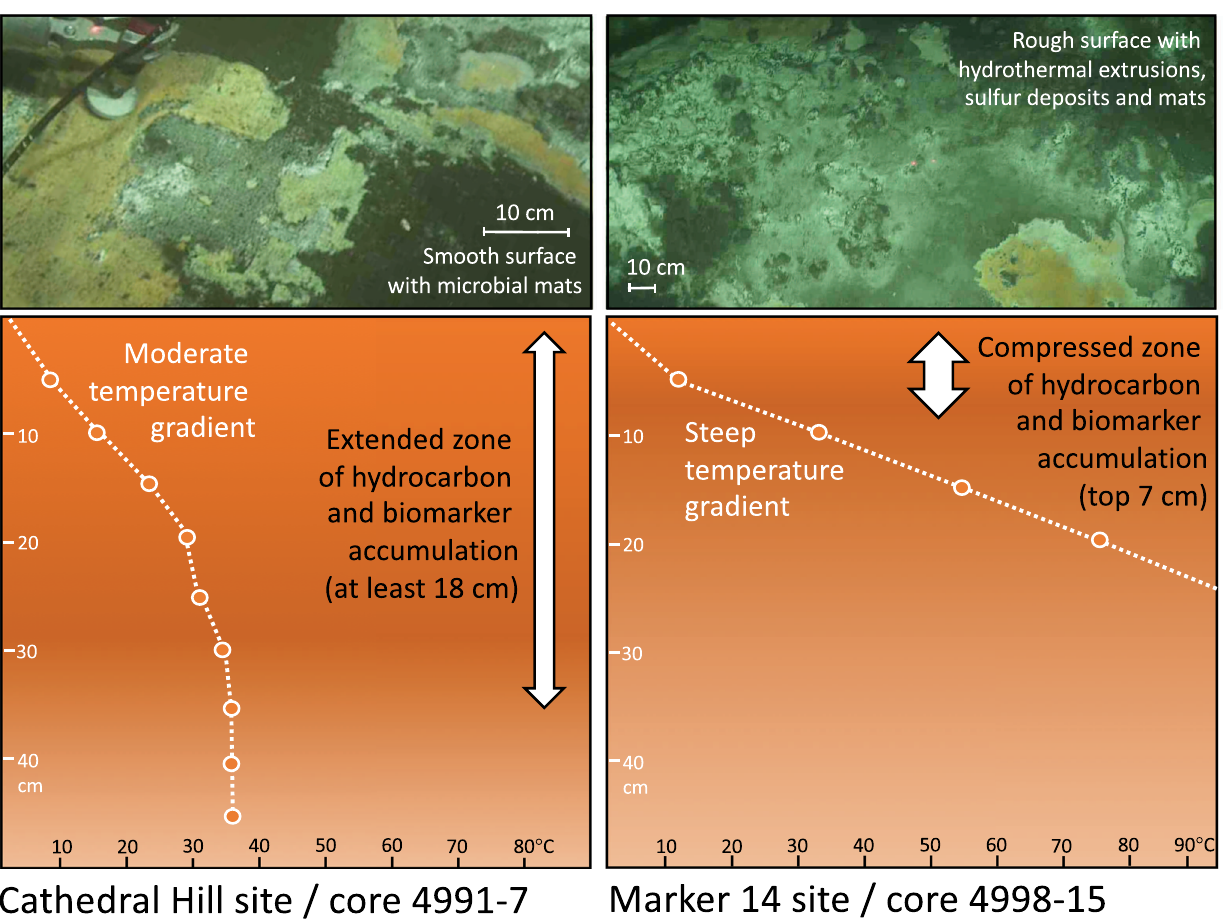
Fig. 8 Overview of contrasting thermal regimes at Cathedral Hill and Marker 14 sites in Guaymas Basin. At Cathedral Hill, moderate temperature gradients extend the zone of hydrocarbon and biomarker accumulation deeper into the sediments than at hotter Marker 14, where steep temperature gradients compress the zone of hydrocarbon and biomarker accumulation into the top ~7